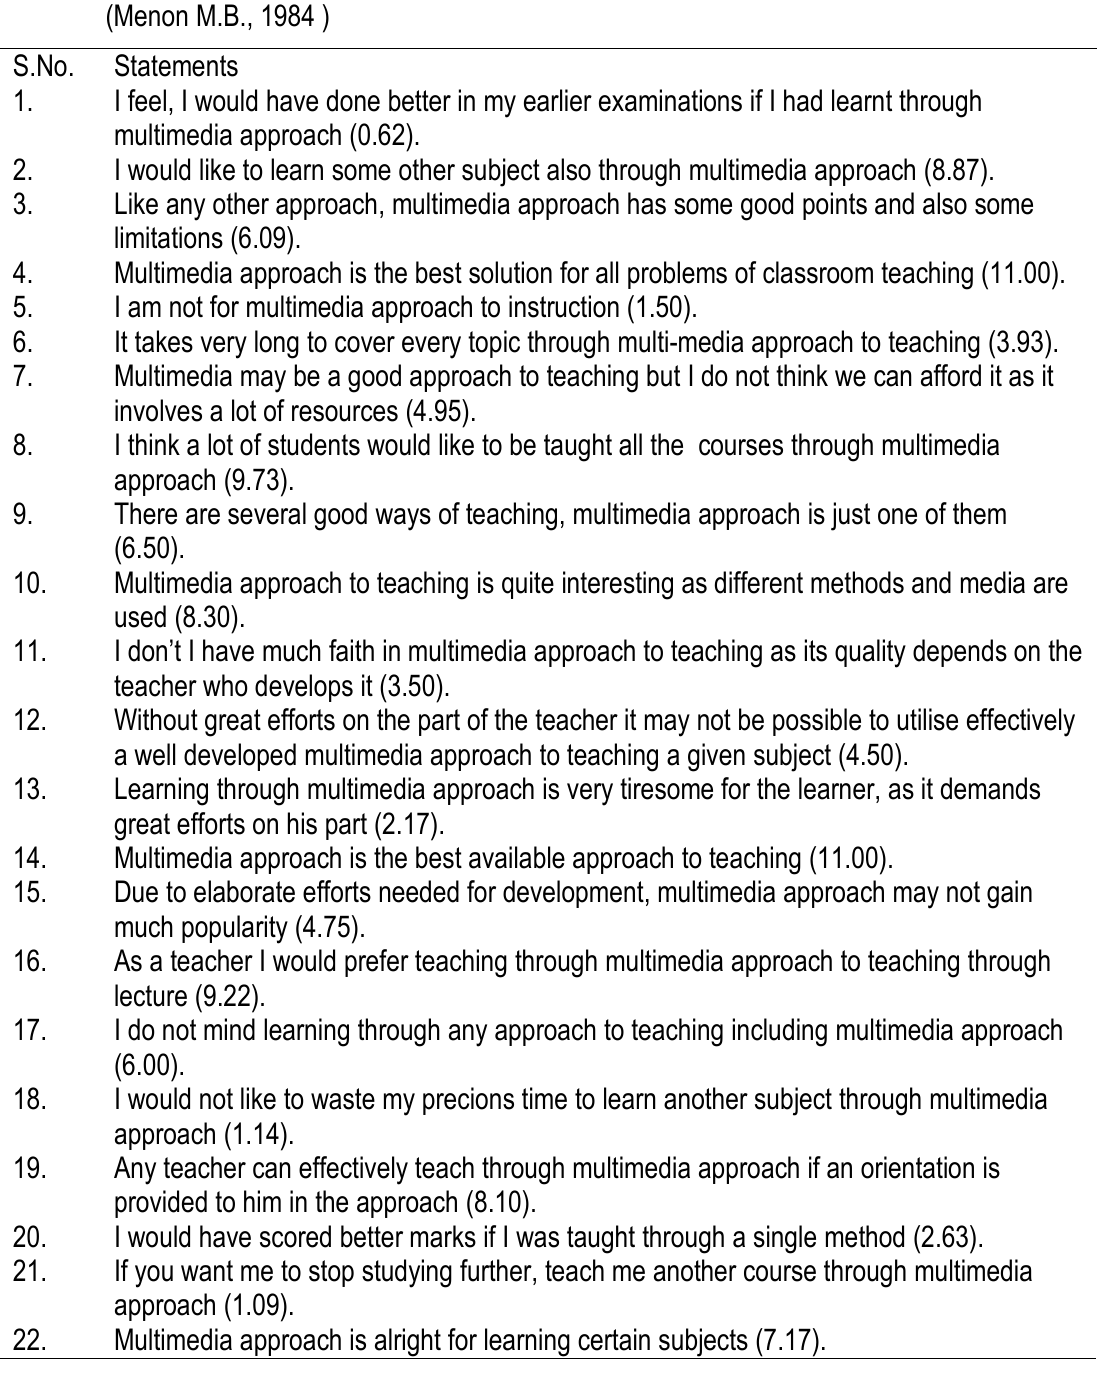
Table-1. Attitude Scale: To measure the attitude of students to multimedia approach to